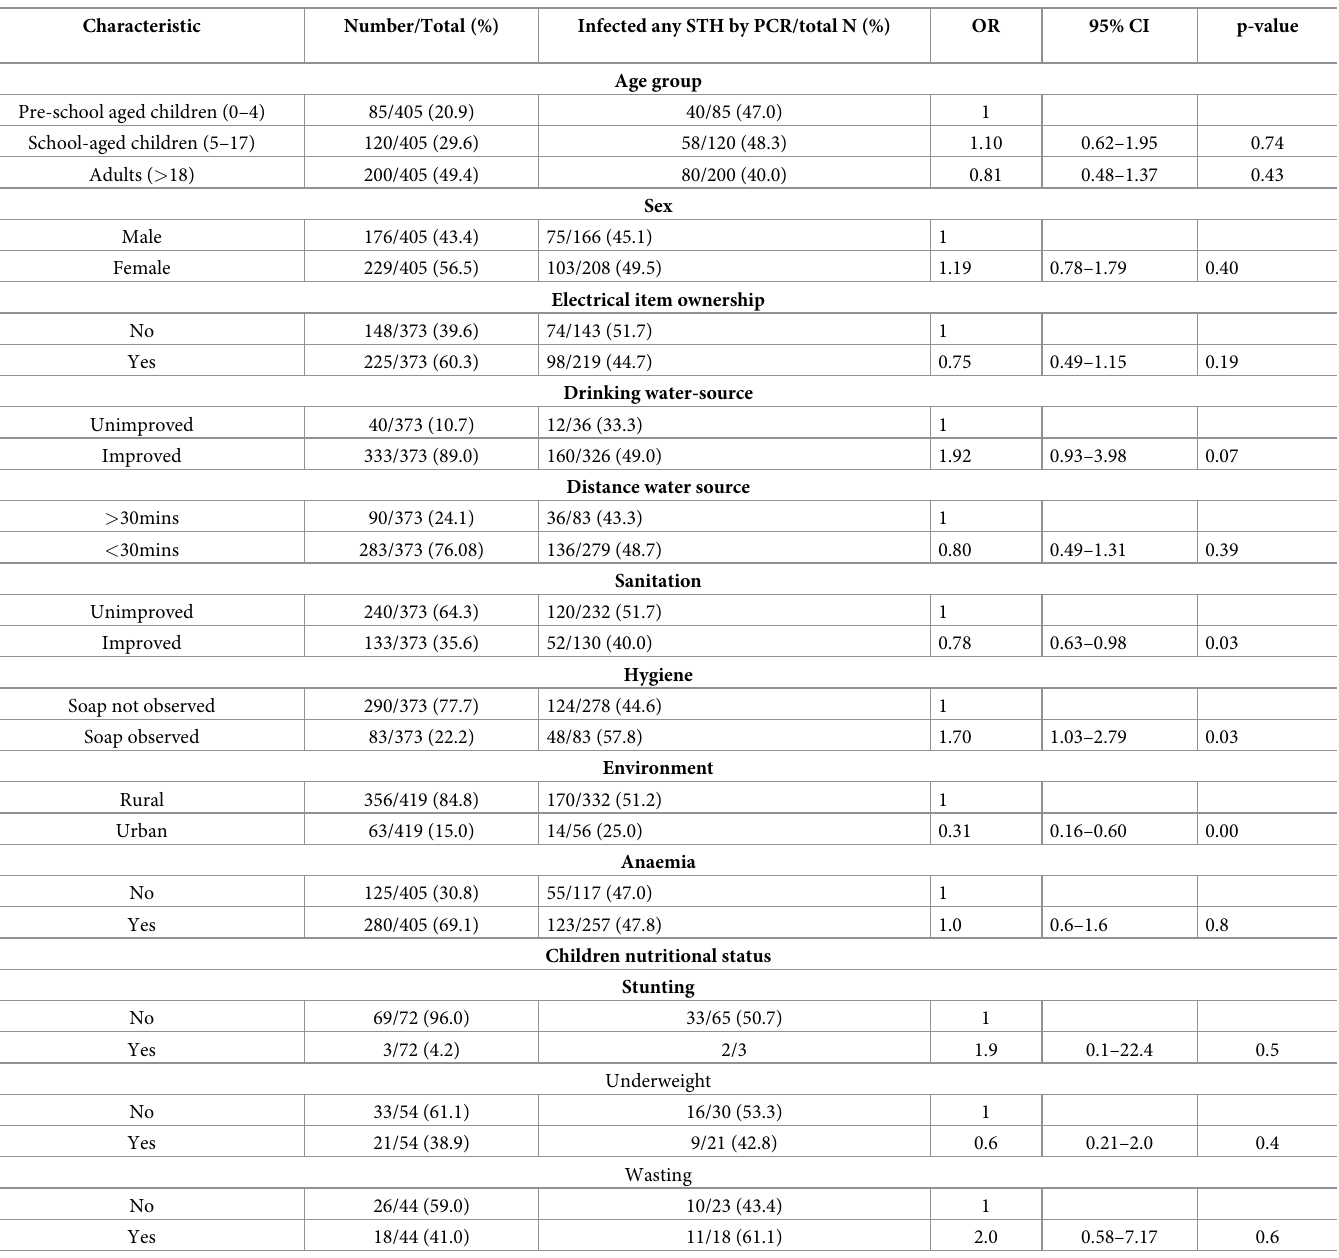
Table 3. Baseline characteristics of study population.